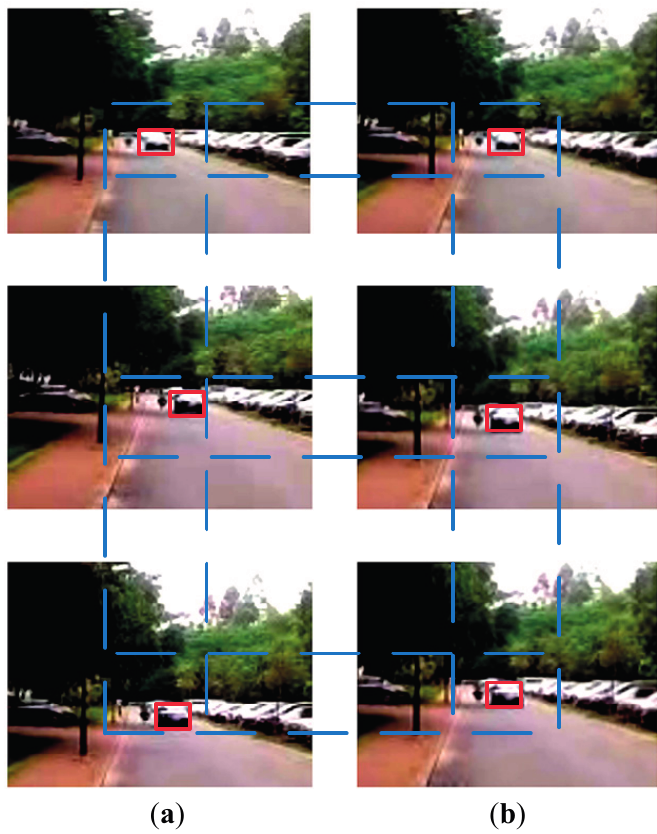
Figure 8. ( a ) the vibrating images; ( b ) those compensated by the optical stabilization method, using two DMs, the car in the image sequences was marked in red